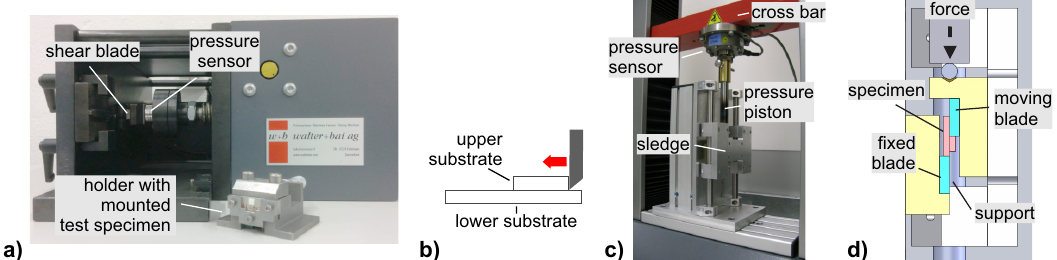
Figure A2. Experimental devices used for shear testing: ( a ) conventional shear tester and ( b ) test principle in ( a ) (sample holder not shown); ( c ) tensile tester (in compression mode) modified for shear testing; ( d ) schematic cross-section of the sledge and specimen in ( c